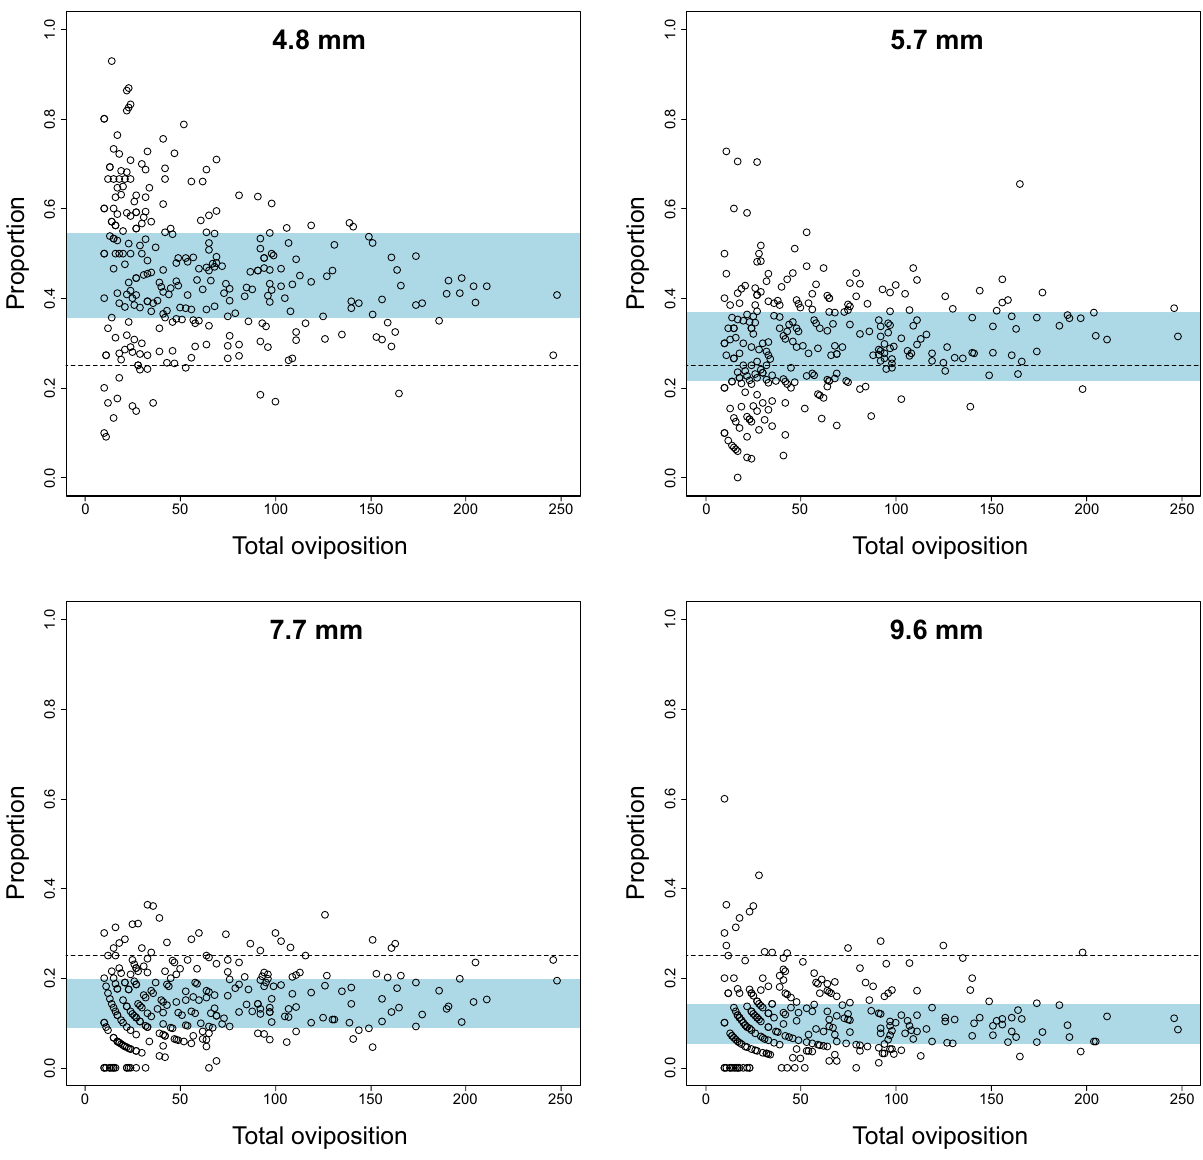
Figure 2. Results of the four-choice assay. The proportion of the number of eggs on each size of substrates to the total egg number on all substrates was plotted. Each point represents a single replicate. Ten replicates were made for each of the 27 strains, in total 270 times of assay were conducted. Dotted lines indicate the proportion of 0.25, the expected value of the null hypothesis (no preference). Shading represents the range of proportion between the upper and lower quartiles that contains 50% of